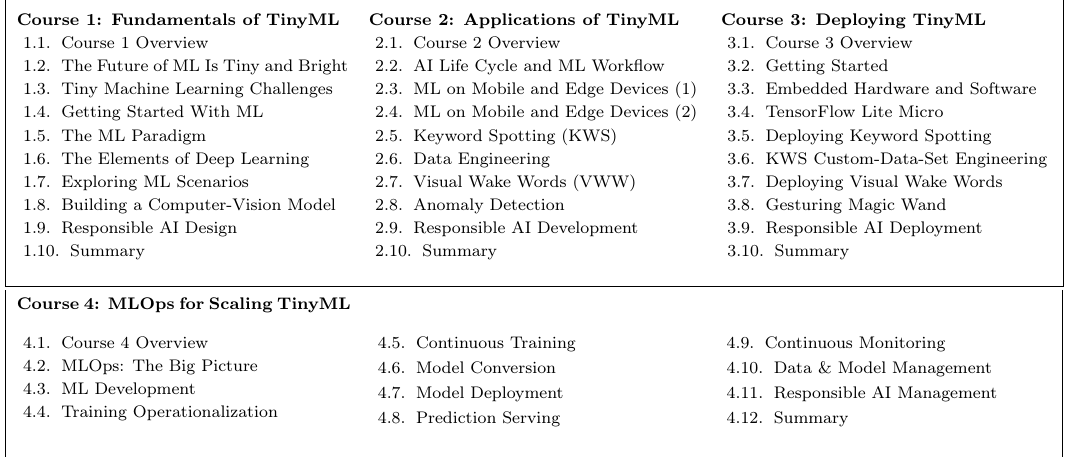
Table 2. A breakdown of topics in the four TinyML courses. Each one has several activities, including videos, colabs, hands-on labs, quizzes, readings, case studies, assign- ments, tests, and discussion-forum